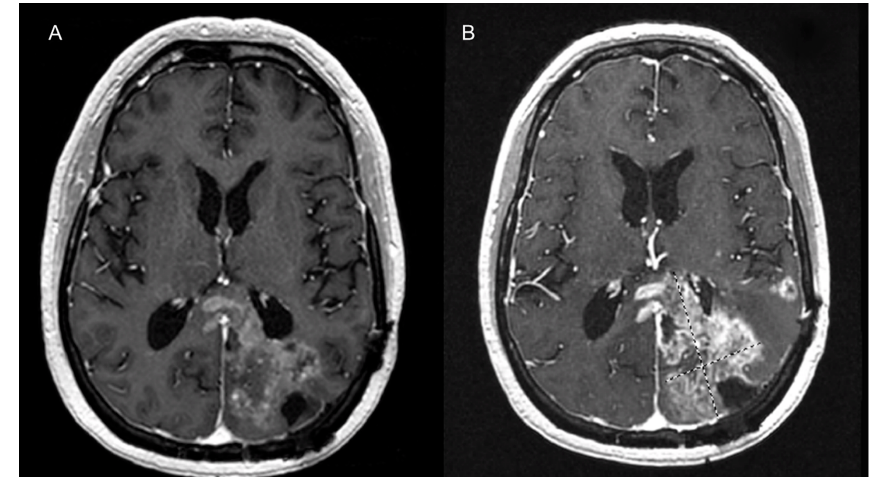
Figure 3. T1 ‐ weighted contrast ‐ enhanced axial image of the brain with a left occipital glioblastoma. ( A ) This image shows enhancing local tumoral recurrence, prior to starting anti-angiogenic therapy. ( B ) Nine months after initiation of anti-angiogenic therapy shows marked reduction of the enhancing component and associated vasogenic edema.